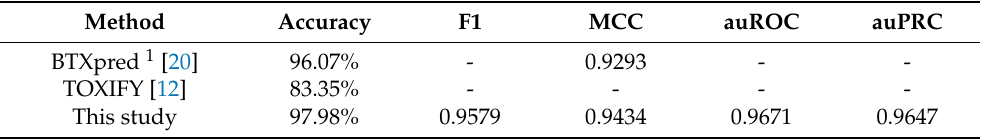
Figure 3. ( a ) Confusion matrix on the test data using the model trained using BTXpred data; ( b ) confusion matrix on the test data using the model trained using the combined VFDB and toxinpred2 data. Table 4. Test results on the toxic bacteria protein dataset. Table 3. Test results on the toxic animal protein dataset.